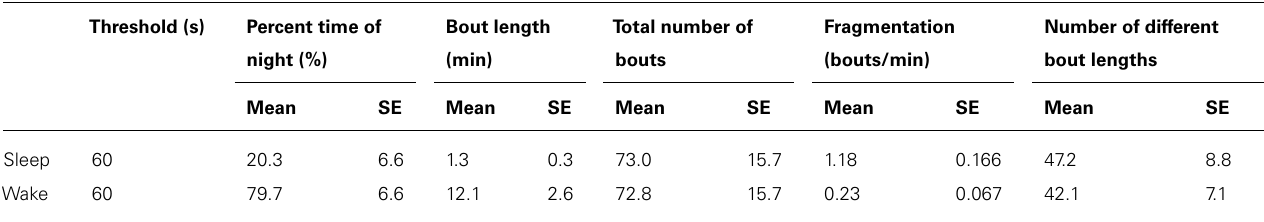
Bout length Total number of (min) bouts